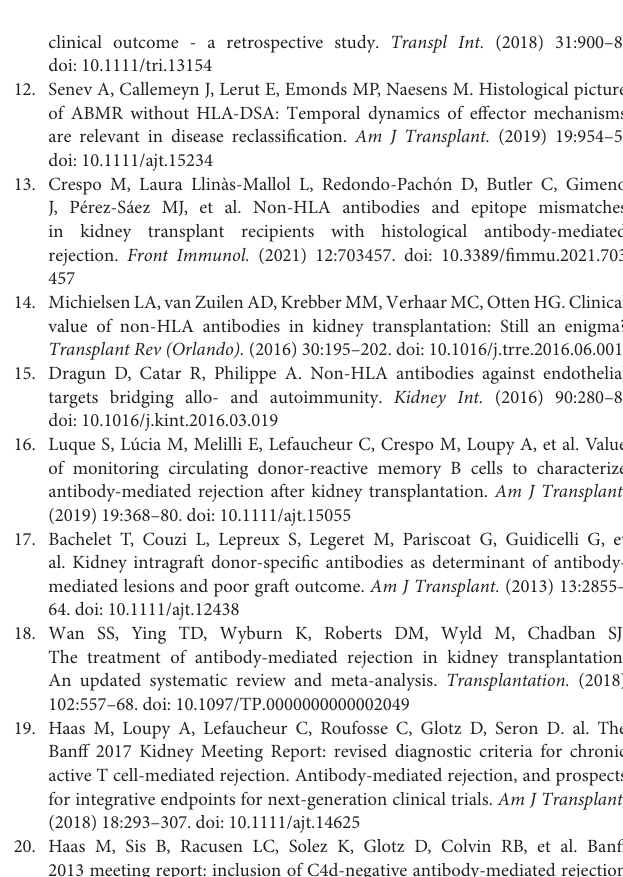
Supplementary Figure 1 | Comparison of allograft survival between recipients who were treated with repetitive applications of IVIG over more than 1 year vs. recipients without long-term therapy with IVIG in the subgroup of patients having late ABMR and positive DSA